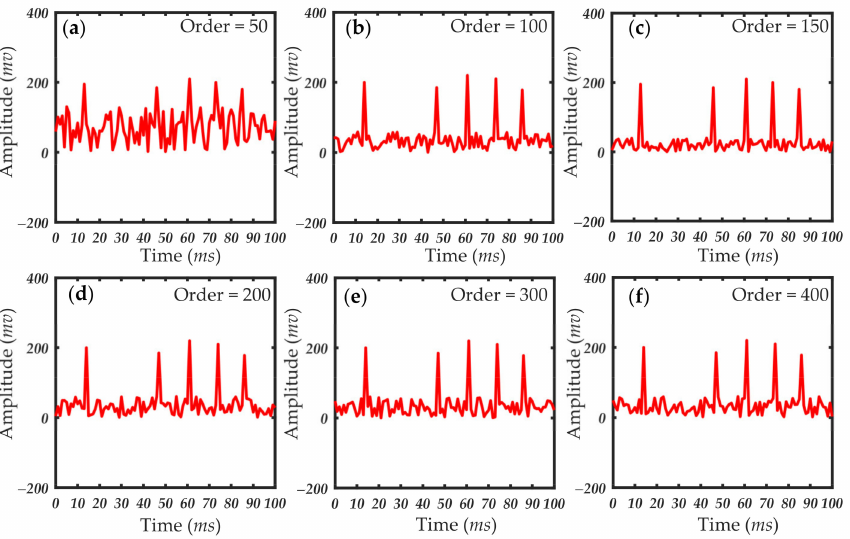
Figure 10. Results of 1 µ m particles under different filter order settings: ( a ) filter order = 50; ( b ) filter order = 100; ( c ) filter order = 150; ( d ) filter order = 200; ( e ) filter order = 300; ( f ) filter order = 400.